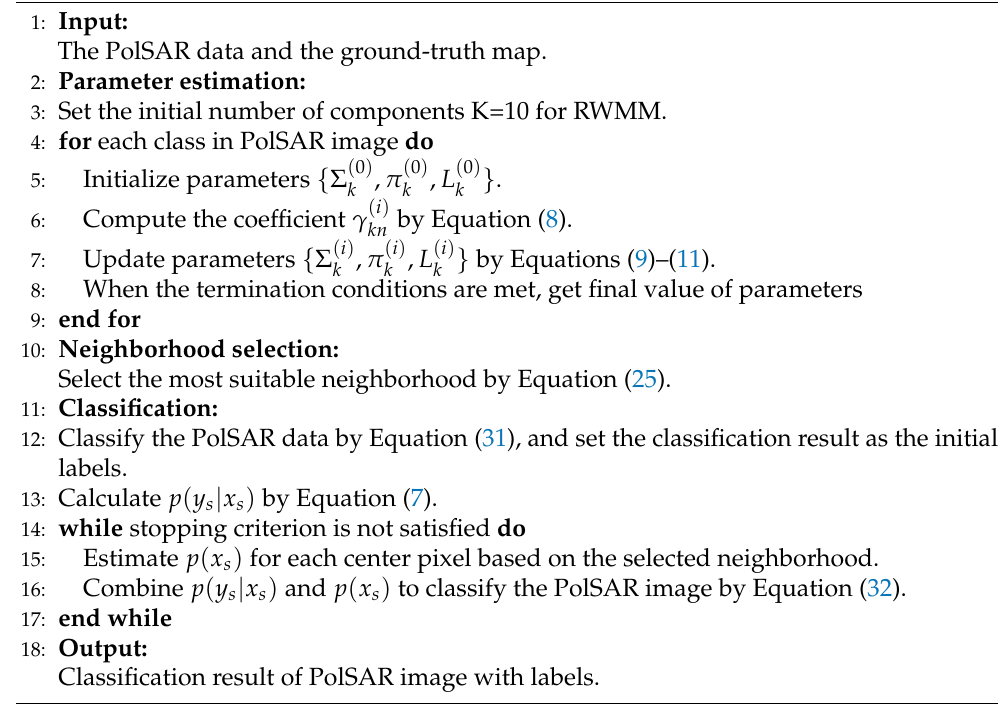
Algorithm 1 RWMM-MRF Supervised Classification